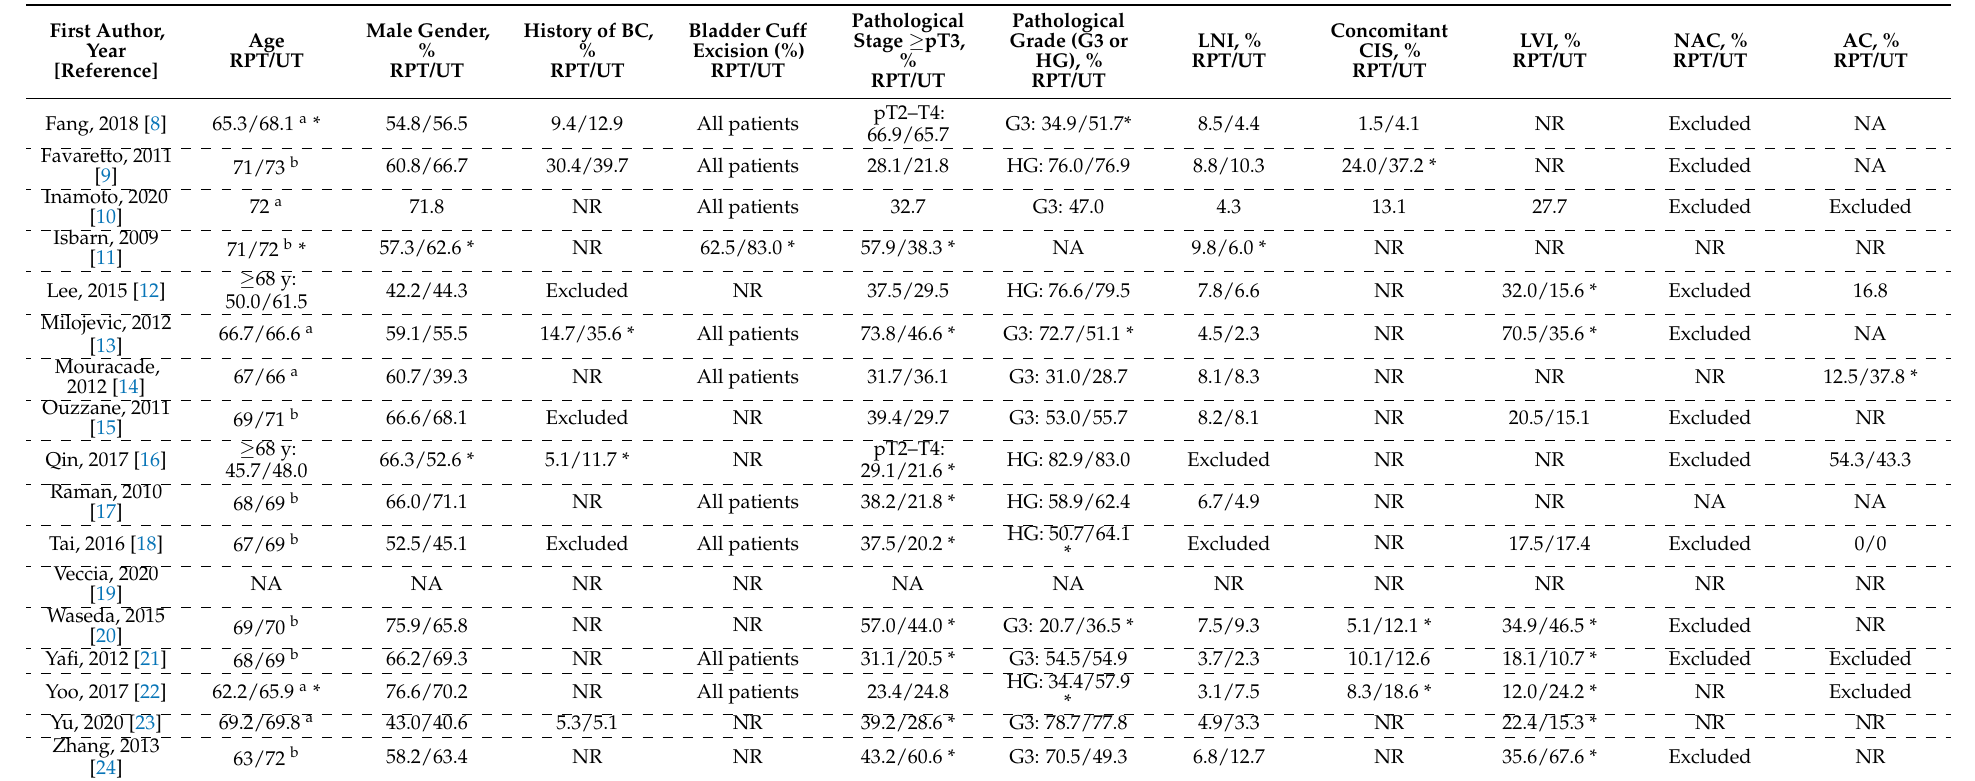
Table 2. Clinicopathological characteristics of included